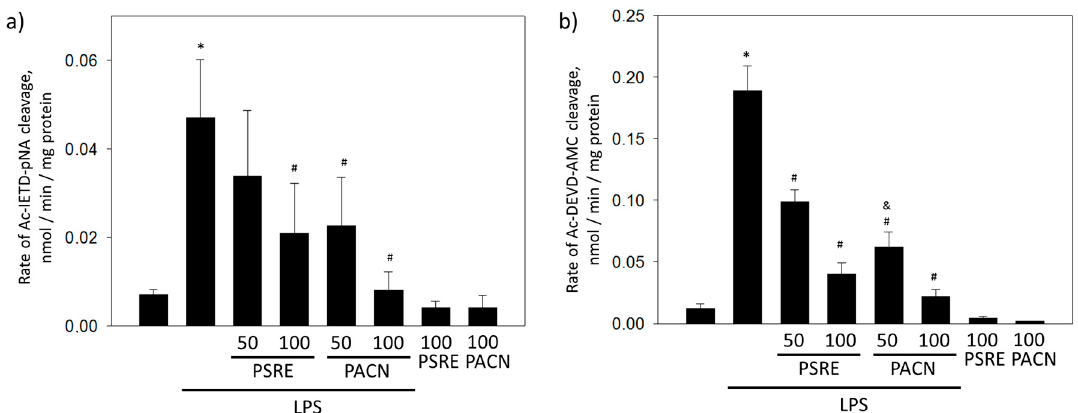
Figure 4. The effect of Pelargonium sidoides root extract (PSRE) and proanthocyanidins from PSRE (PACN) on LPS-induced caspase-8 ( a ) and caspase-3 ( b ) activation in gingival fibroblasts. Fifty and 100 represent the concentrations expressed in µg/mL. The data are presented as means with standard deviation of seven experimental repeats. *—significant difference compared to untreated control, #—significant difference compared to LPS only treatment and &—significant difference compared to LPS plus 50 µg/mL PSRE treatment, p < 0.05.